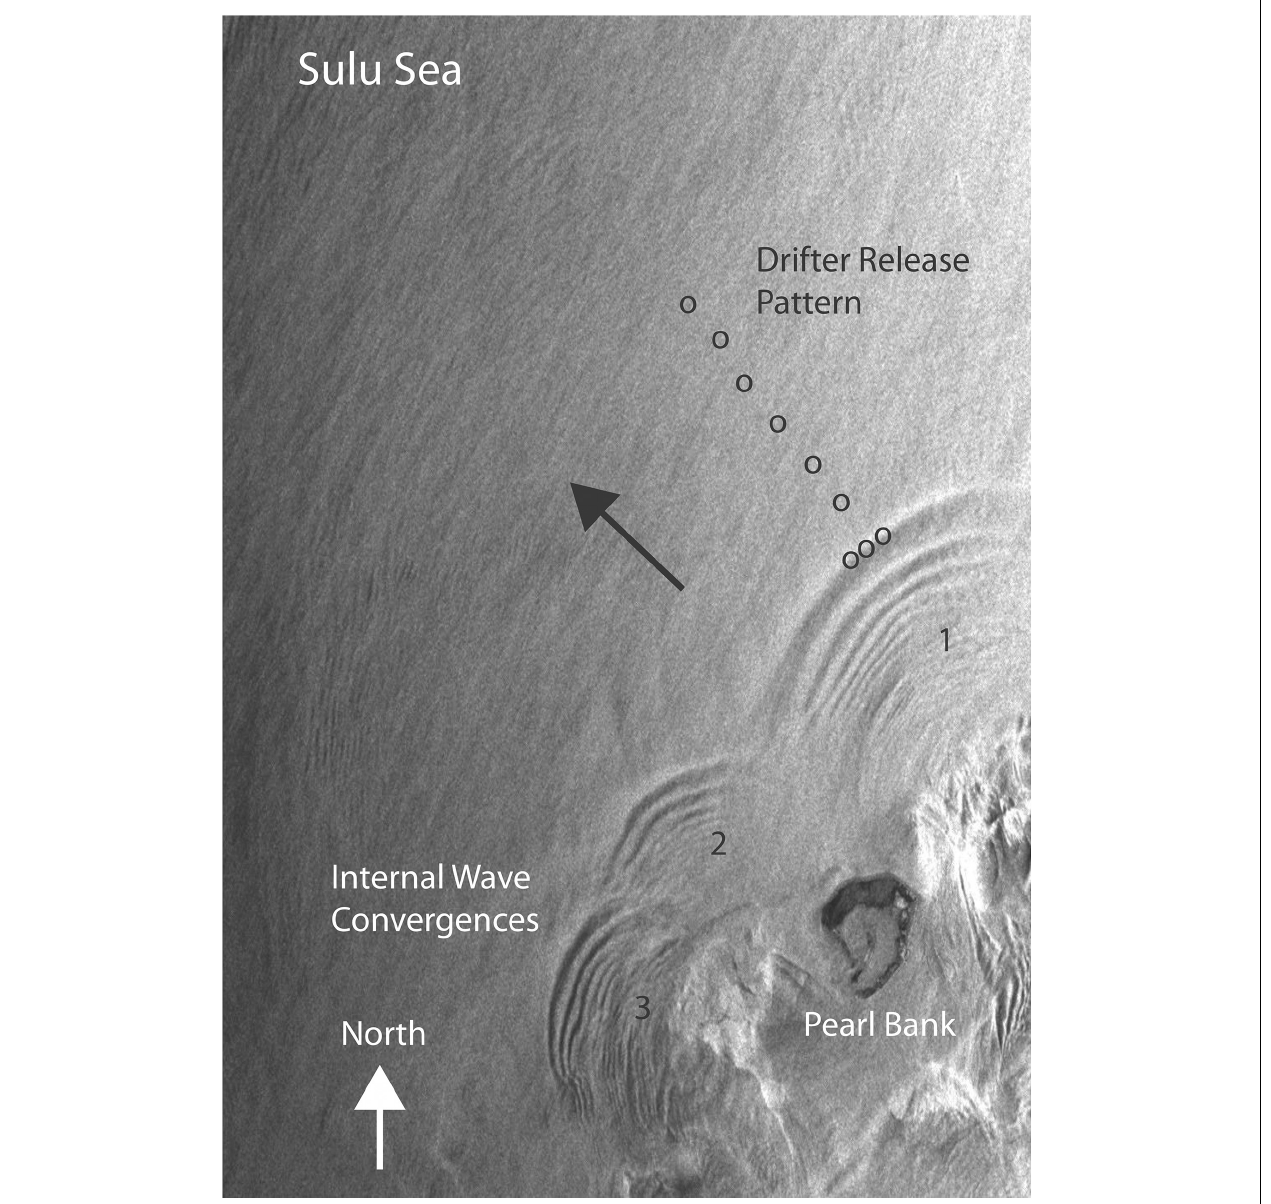
FIGURE 5 | Synthetic aperture radar (SAR, C-band, VV) satellite image of three sets of internal wave convergences (labeled 1–3), which have been formed by the interaction of tidal currents with the Pearl Bank in the Sulu Sea (5.85 N, 119.85 E). The arrow indicates the direction of propagation of the internal waves. This image is used to describe the experimental design of the field sampling. A set of internal wave convergences was first located from a boat. In front of the set of convergences, a line of plastic surface floats was deployed (indicated by the black circles). A neuston net was then used to sample the zooplankton and floating debris within the convergences. After the plankton sampling, the surface drifters were located and note was taken if they were within a convergences or not and if transport by the convergences had occurred, an estimate of the distance to which they were carried was made. Image area is 100 × 100 km and is from https://earth.esa.int/web/guest/missions/esa-operational-eo-missions/ers/instruments/sar/applications/tropical/-/asset_publisher/tZ7pAG6SCnM8/content/